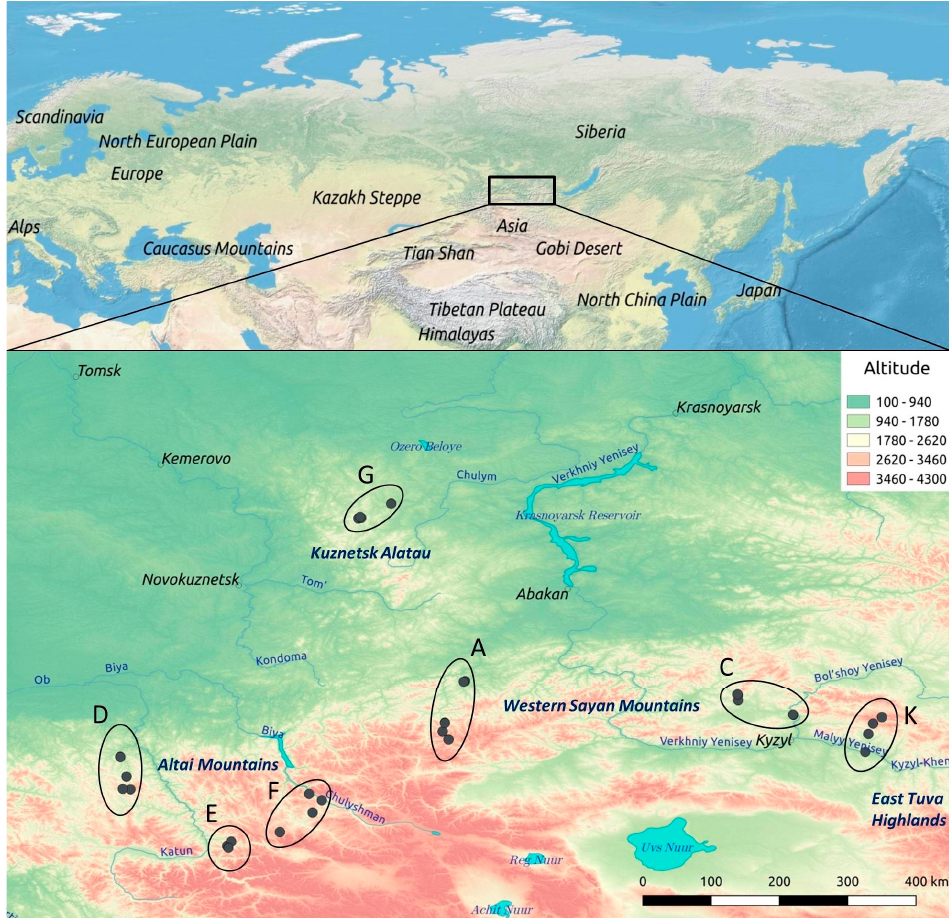
Figure 13. Locations of the studied samples in the Altai-Sayan region. A: Sayan Pass region, along the Abakan-Ak-Dovurak highway, south of the town of Abaza, the border of Khakassia and Tyva, the Dzhebash Ridge and the Western Sayan Mountain range; C: near the town of Turan, the border of Khakassia and Tyva, the Kurtushibinsky Ridge and the Western Sayan Mountain range; D: north of the Seminsky Pass, Chuisky Trakt, Shebalinsky District, the Republic of Altai, Seminsky Range and the Altai Mountains; E: Ongudaysky District, the Republic of Altai, Achik Pass, Bely Bom mountain, North Chuysky Ridge and the Altai Mountains; F: Ulagansky District, the Republic of Altai, western bank of the Chulyshman River, Ulagan Highlands and the Altai Mountains; G: near the village of Priiskovy, the Republic of Khakassia and Kuznetsk Alatau; K: western part of the Kaa-Khemsky District of Tyva, Academician Obruchev Ridge and the East Tuva